Question: Write a single sentence explaining what this figure depicts.
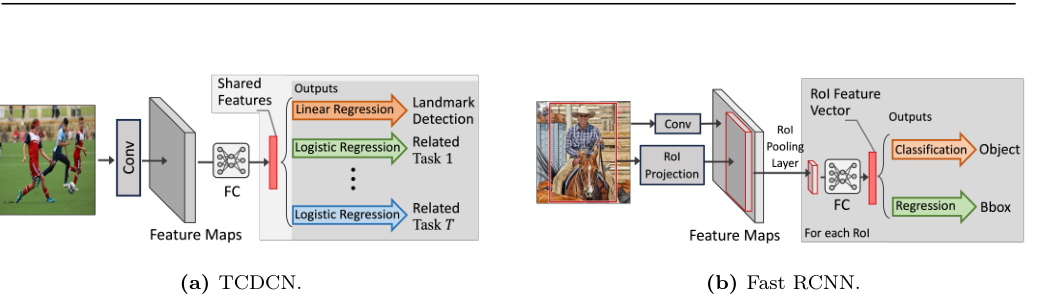
Answer: Two of the earliest applications of hard-parameter sharing in CNNs: (A) the Tasks-Constrained Deep Convolutional Network (TCDCN), which jointly extracts common features from human faces for multiple tasks such as landmark detection, head pose estima- tion, and facial attribute inference; and (B) the Fast Region-based Convolutional Network method (Fast R-CNN), where each region of interest (RoI) is projected into a fixed-size feature map first and then mapped to a feature vector used for both object probability prediction and bounding-box offsets regression.